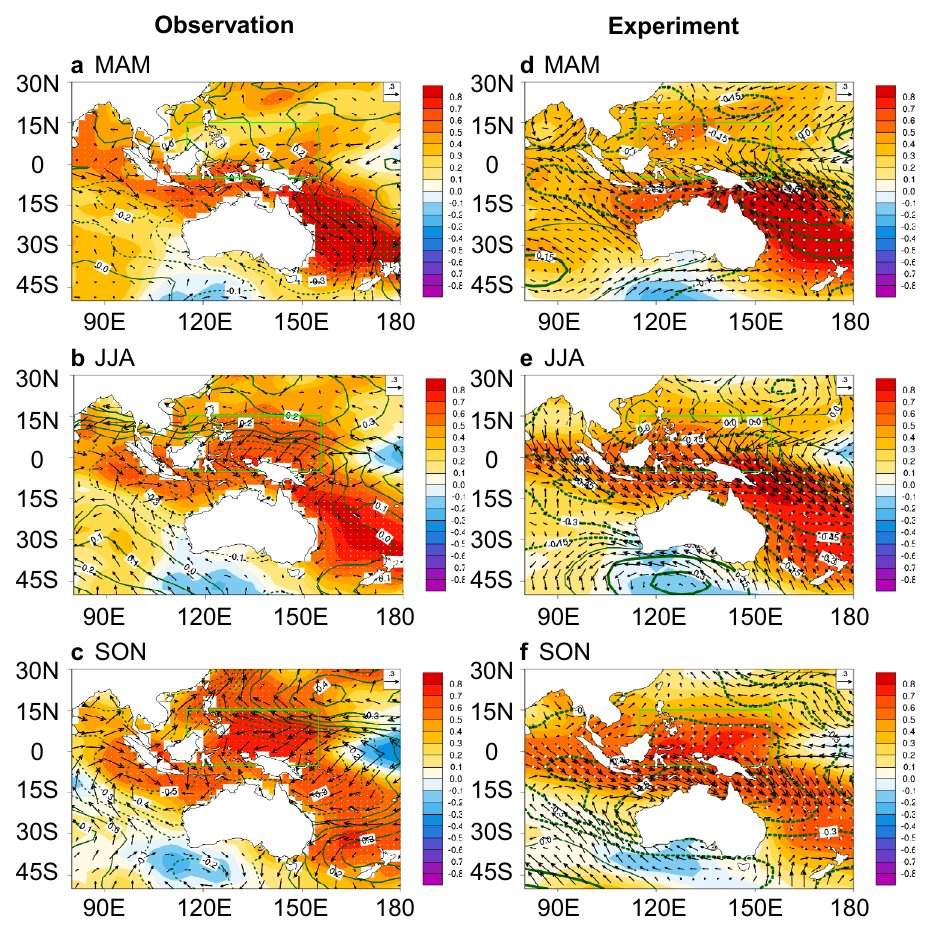
Fig. 2 Interhemispheric propagation of SST variability. The correlations maps of the MAM SWP SST index with the observed SST (shading), sea level pressure (contour) and winds (vector) in the a MAM, b JJA, c SON seasons for the period 1979 – 2019. d – f are for the simulation results of SWP_EXP pacemaker experiment (see Methods for details). The white dotted shading indicates the correlation is signi fi cant at the 95% con fi dence